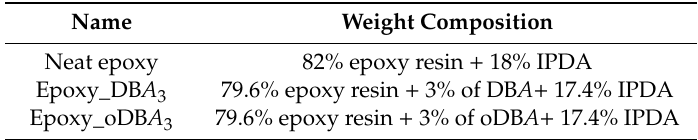
Table 2. Names and compositions of mixtures.